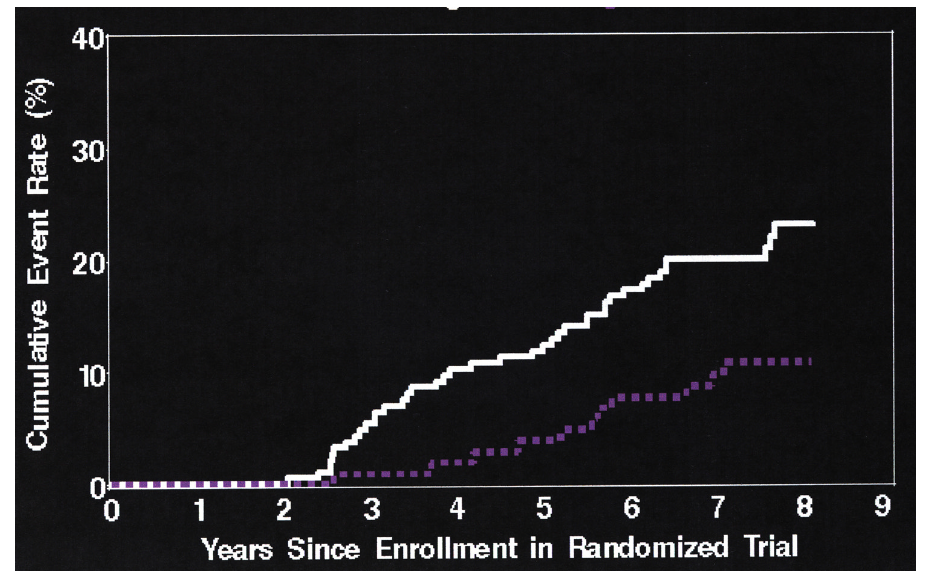
FIGURE 2. Cumulative mortality according to HbF levels after the conclusion of the randomized portion of the MSH. White line represents patients with HbF <0.5 g/dL and lavender line patients with HbF >0.5 g/dL ( p = 0.03).